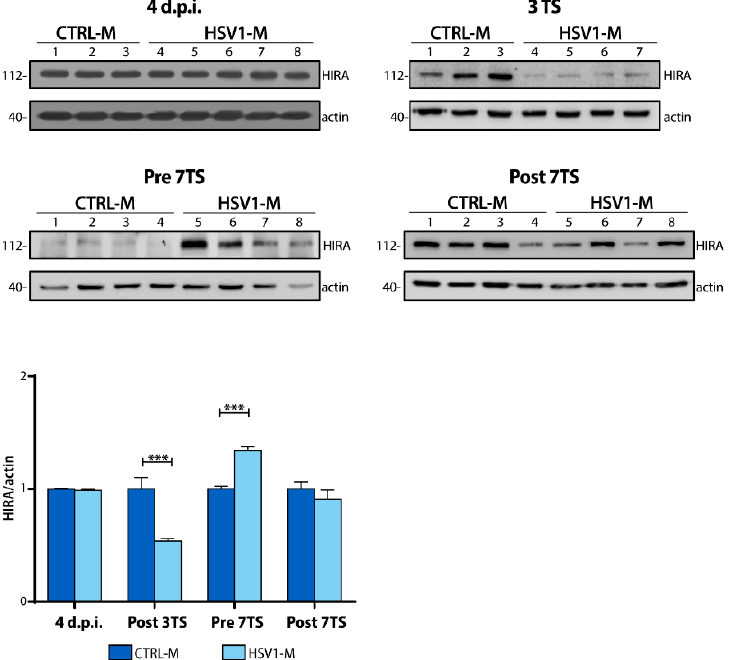
Figure 5. HIRA protein expression in the cortex of recurrent HSV-1 infection mouse model. Representative WBs of HIRA protein expression 4 d.p.i., 24 h after the 3rd and the 7th TS (Post 3TS and Post 7TS respectively), or 24 h before the 7th TS (Pre 7TS). Densitometric analyses were performed with ImageLab software and normalized to actin expression level. The values represent the normalized fold-changes in protein levels from HSV1-M with respect to CTRL-M (bar graph on the left). Data are mean ± SEM. *** p < 0.001. Statistical significance was calculated by multiple t-tests and determined using the Sidak–Bonferroni method (bar graph, alpha = 0.05).